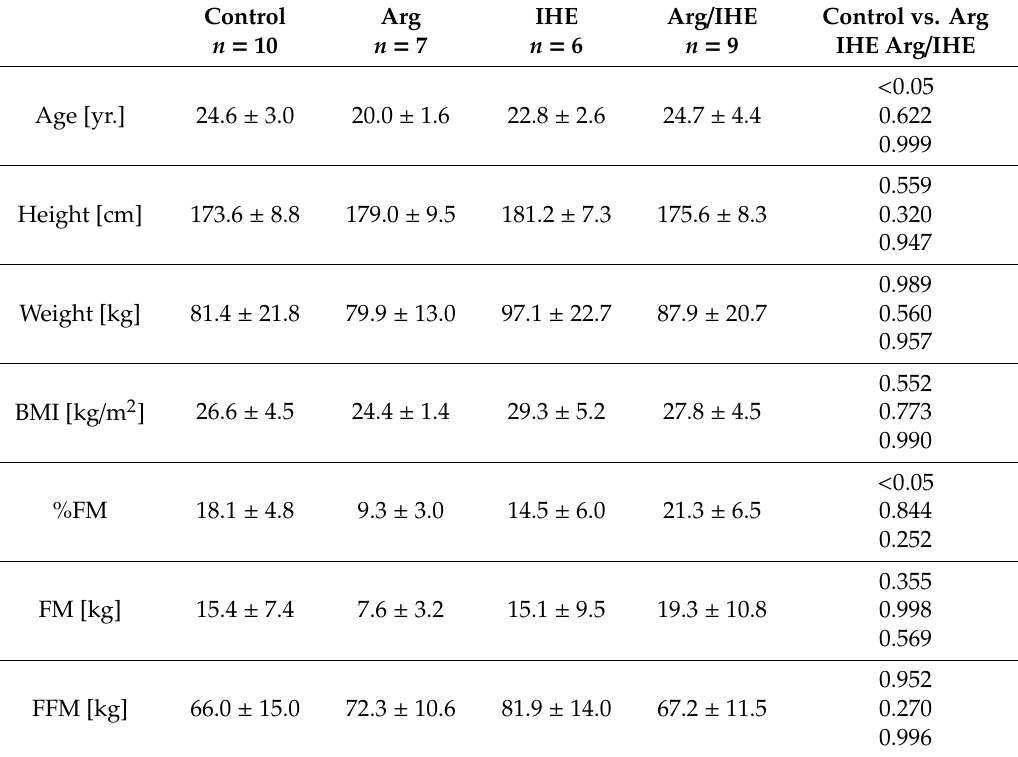
Table 1. Anthropometrics and body composition (mean ±